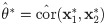
Comparison of the bootstrap implementations, when bootstrapping Pearson’s sample correlation, θ^*=co^r(x1*,x2*), for sample sizes varying from 15 to 915.The data was simulated according to x
1i = ϵ
1i, x
2i = x
1i+ϵ
2i, ϵ
ji ∼ N(0,1), j = 1,2. Results based on 10,000 (panels a-d), 100,000 (panels e-h), and 1,000,000 (panels i-l) bootstrap replications. The left panels (a, e, and i) compare the approach’s time expenditures. The remaining panels show the computation time ratios (in log scale) comparing the resampling approaches against the vectorized implementation. The horizontal line is set at zero and represents the threshold below which the data resampling approach outperforms the vectorized implementation.